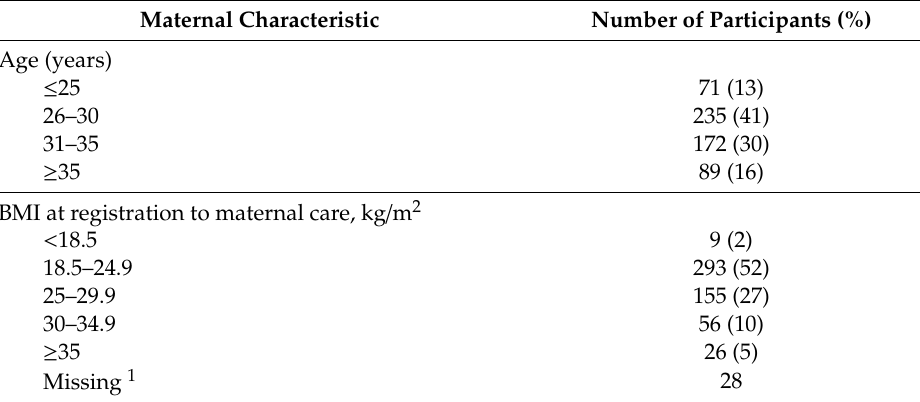
Table 1. Maternal characteristics ( N = 567).